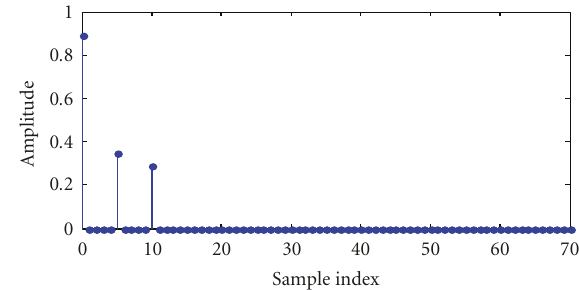
Figure 6: Rayleigh fading channel impulse